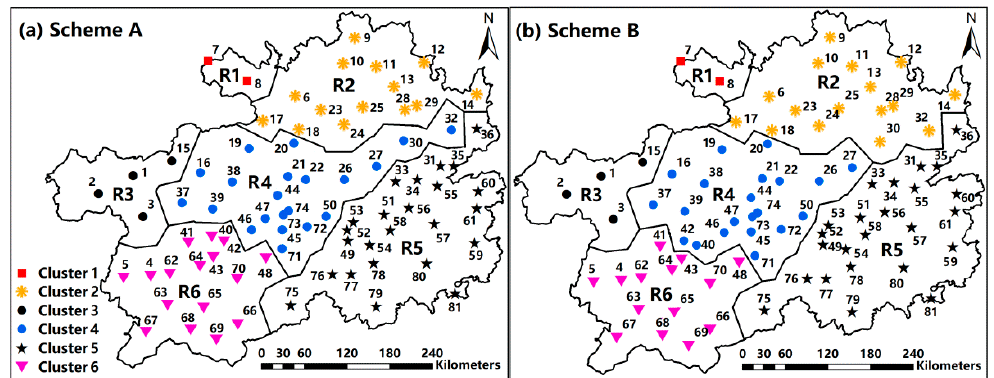
Figure 4. The clustered sub-regions by Scheme A and B.